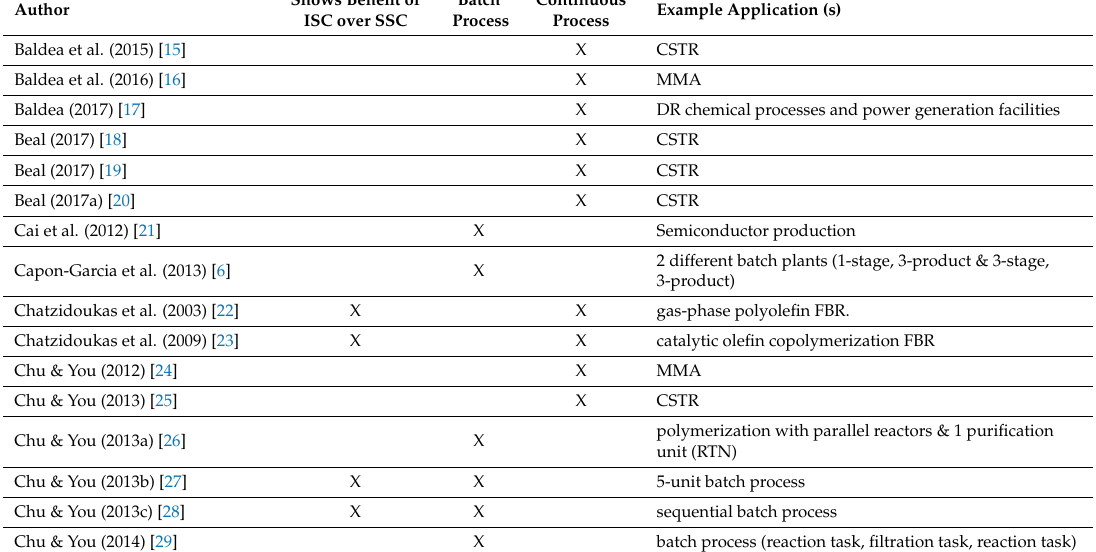
Table 1. Economic benefit of integrated scheduling and control (ISC) over segregated scheduling and control (SSC) (CSTR: continuously stirred tank reactor; MMA: methyl methacrylate; DR: demand response; FRB: fluidized bed reactor; RTN: resource task network; ASU: air separation unit; HIPS: high-impact polystyrene; PFR: plug flow reactor; SISO: single-input single-output; MIMO: multiple-input